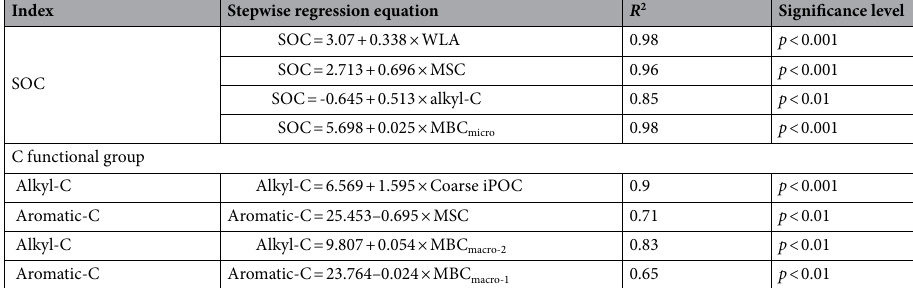
Table 2. Relationships among soil organic C, C functional group contents, organic C physical components and water-able aggregate. SOC soil organic C in 0–20 cm bulk soil, WLA large macroaggreagate, MSC mineral- incorporated organic carbon in macro-aggregates, coarse iPOC coarse intra-particulate organic carbon in macro-aggregates, MBC micro microbial biomass carbon within in micro-aggregate, MBC macro-1 microbial biomass carbon within in small macro-aggregate, MBC macro-2 microbial biomass carbon within in large macro- aggregate.